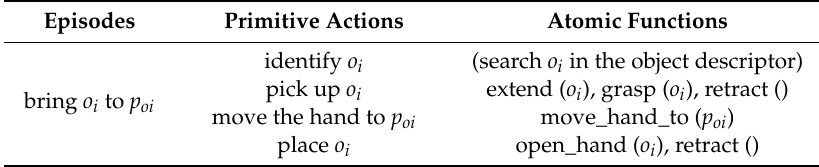
Table 3. An example of action events with the action